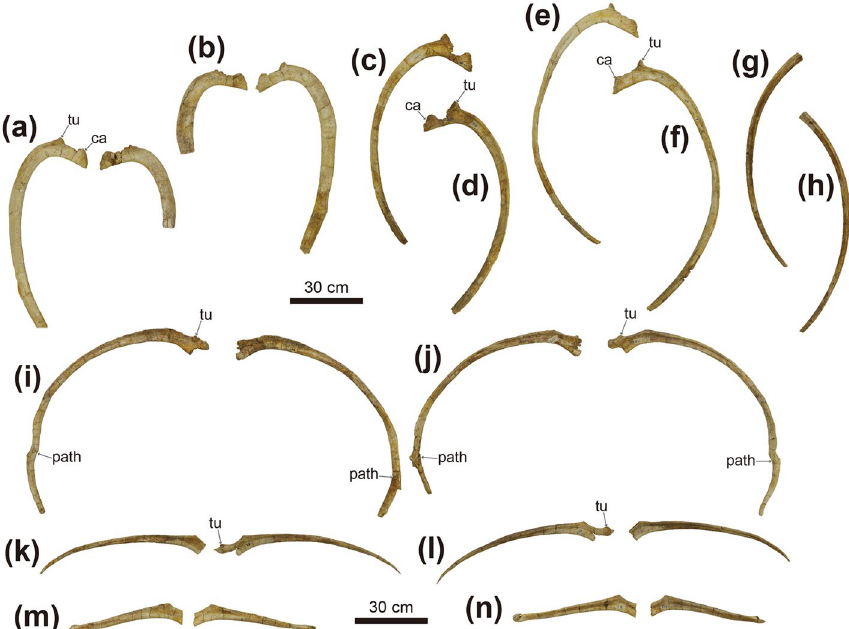
Figure 5. Photographs of dorsal ( a – h ) and dorsosacral ribs ( i – p ) of Tarchia tumanovae sp. nov. (MPC-D 100/1353). Both third dorsal ribs in ( a ) anterior and ( b ) posterior views. The fourth left dorsal rib in ( c ) anterior and ( d ) posterior views. The fifth left dorsal rib in ( e ) anterior and ( f ) posterior views. The sixth left dorsal rib in ( g ) anterior and ( h ) posterior views. Both first dorsosacral ribs in ( i ) anterior and ( j ) posterior views. Both second dorsosacral ribs in ( k ) anterior and ( l ) posterior views. Both third dorsosacral ribs in ( m ) anterior and ( n ) posterior views. ca capitulum, path pathology, tu